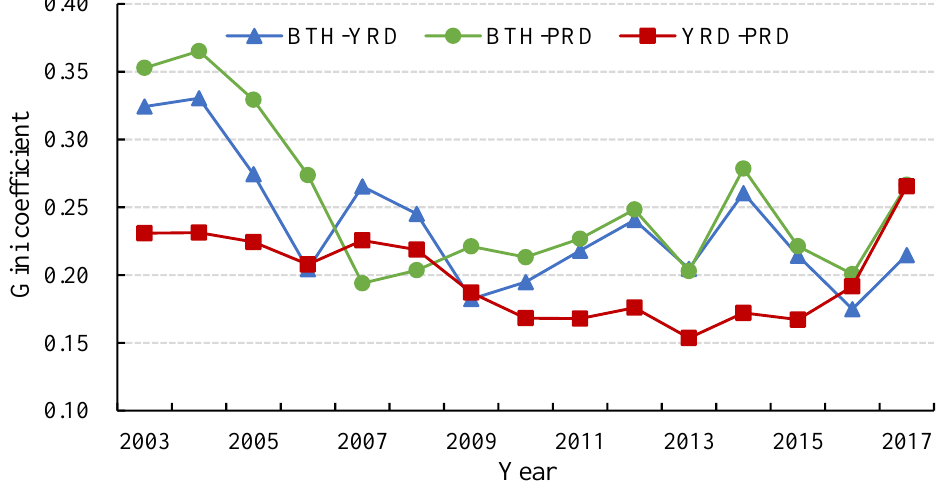
Figure 6. Inter-regional Gini coefficients of CEE in China’s three major urban agglomerations. From 2003 to 2017.